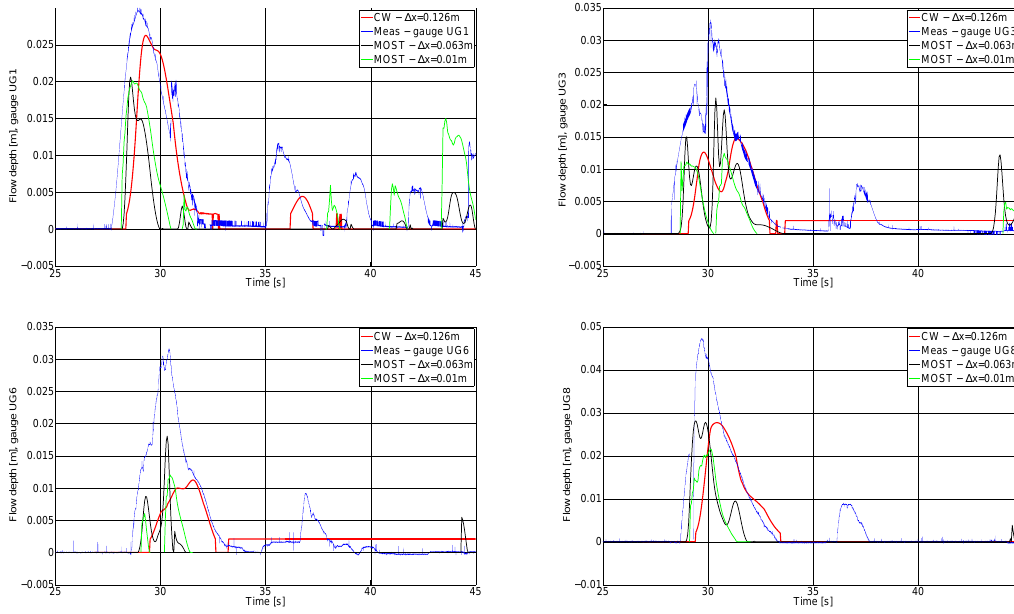
Figure 12. Simulated near-shore wave surface elevation and overland flow depth in Geiranger for Coulwave and